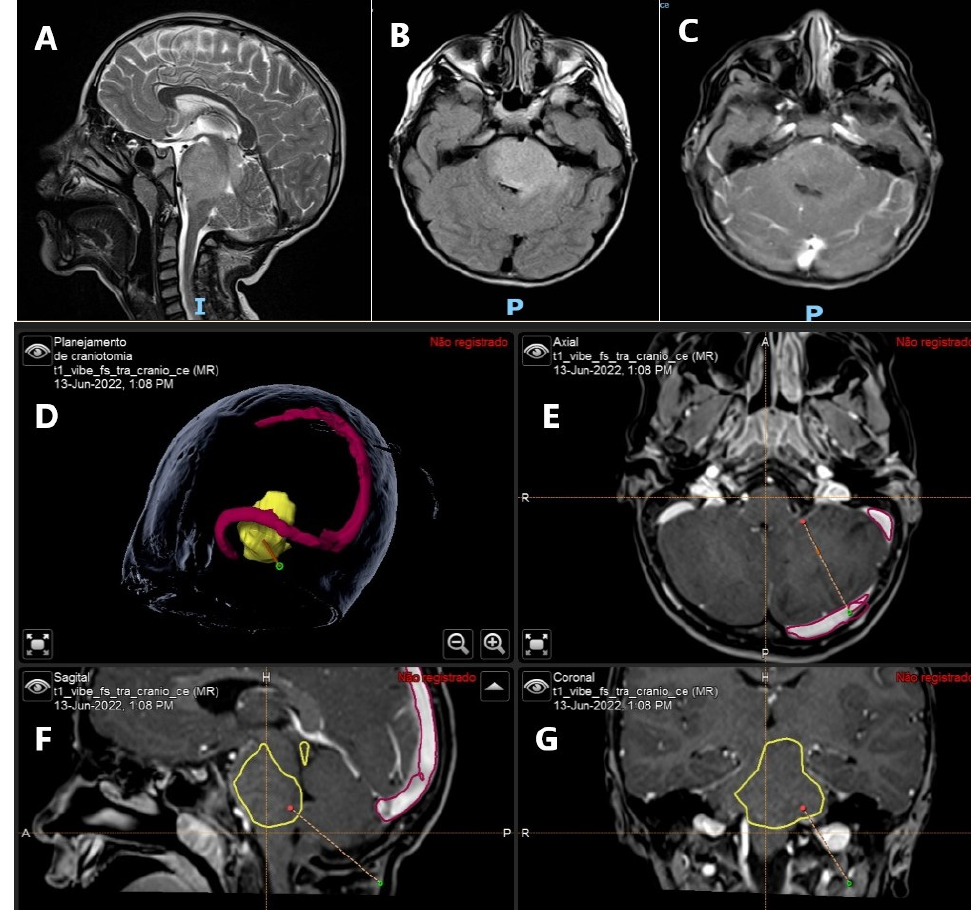
Figure 2. Diffuse intrinsic pontine glioma in a 5-year-old boy. ( A ) Sagittal MRI T2-WI demonstrating diffuse enlargement of the pons. ( B ) Axial T2-Flair image. ( C ) Axial T1-gad showing absence of contrast enhancement. ( D – G ) Frameless neuronavigation system planning for tumor biopsy and further molecular study of the tumor. ( D ) Brain lesion is observed in yellow and the transverse and sagittal sinuses in red. ( E ) Axial T1 contrast enhanced. Dotted line showing the planned biopsy trajectory. ( F ) Sagittal T1 contrast enhanced. View of the tumor demarcated in yellow and the tumor biopsy trajectory shown by dotted line. ( G ) Coronal T1 contrast enhanced. View of tumor biopsy trajectory and red dot as the